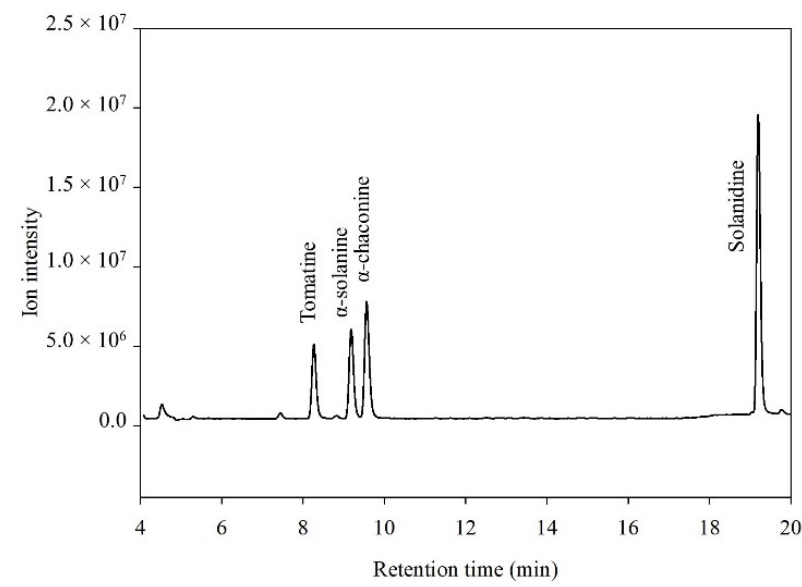
Figure 1. Liquid chromatography–electrospray ionization mass spectrometry ( LC–ESI/MS) chromatogram in full scan mode of standard solutions of tomatine (10 µg mL − 1 ), α -solanine (10 µg mL − 1 ), α -chaconine (10 µ g mL − 1 ), and solanidine (10 µ g mL − 1 ).